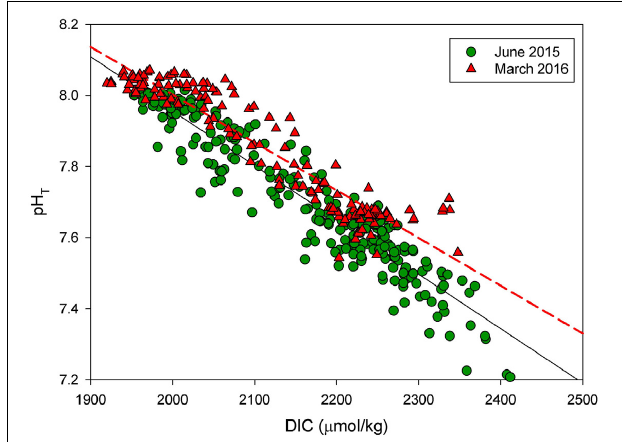
FIGURE 12 | Comparison between dissolved inorganic carbon (DIC) and pH in total scale (pH T